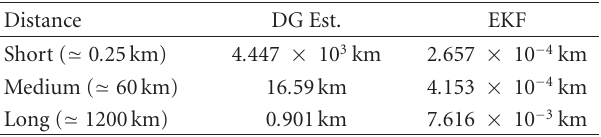
Table 2: Comparing mean RMSE in absolute position: DG Est. versus EKF.